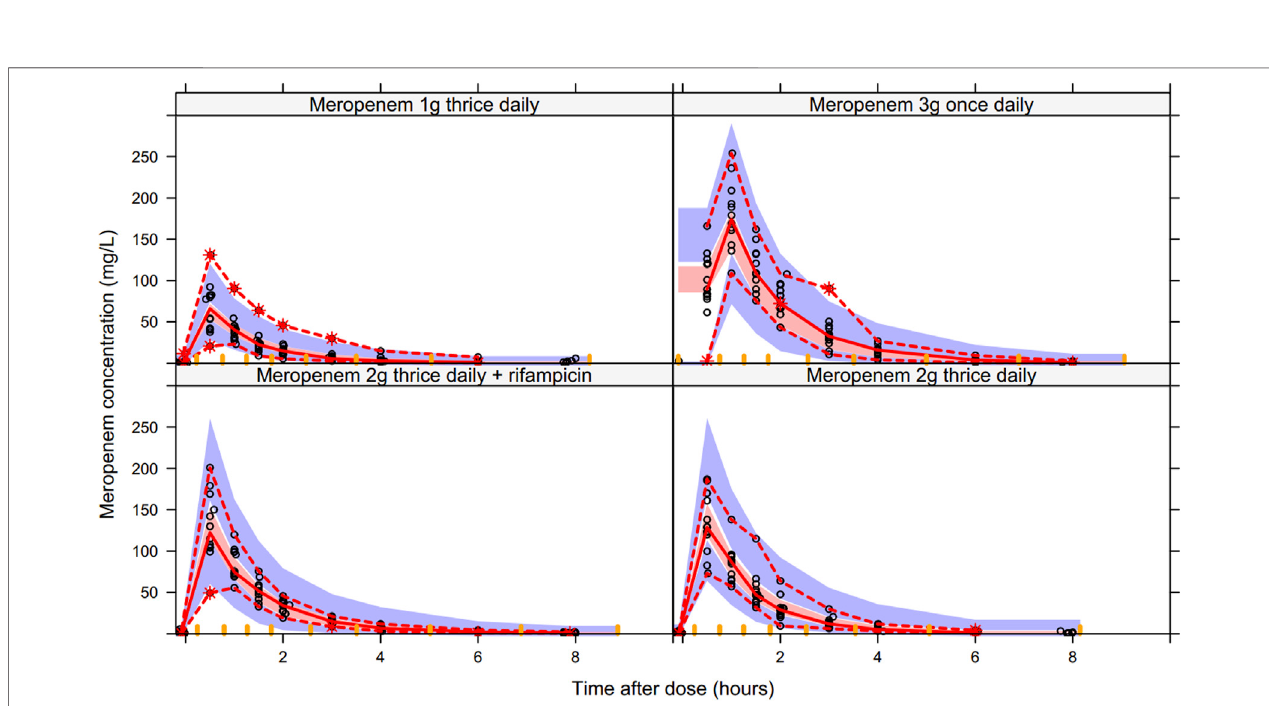
FIGURE 4 | Visual predictive check of the fi nal model strati fi ed by study arms. The dashed red lines represent the 97.5th and 2.5th percentiles of the observed meropenem concentration data (open black circles), the solid red line connects the median (50th percentile) of the observed data ( n (cid:1) 49). The blue shaded areas represent 95% con fi dence intervals of the 97.5th and 2.5th percentiles of the predicted simulated data ( n (cid:1) 1,000), whereas the red shaded area represents 95% con fi dence interval of the median (50th percentile) of the predicted simulated data.